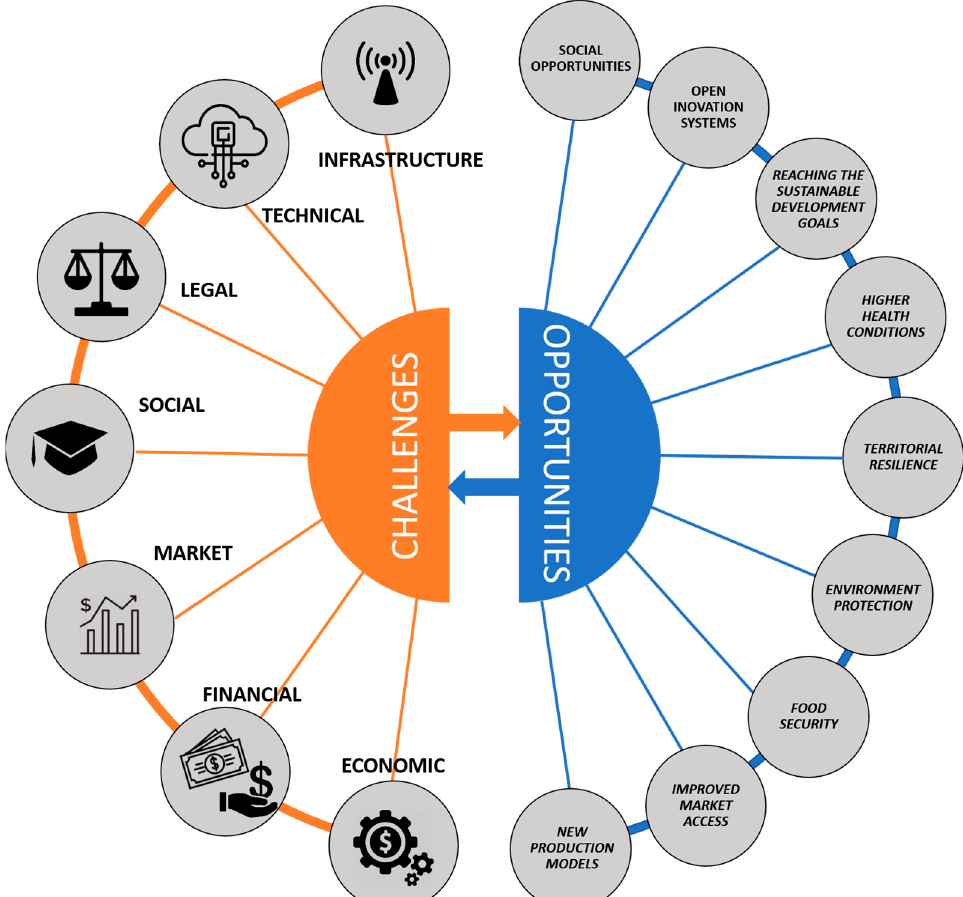
Figure 10. Challenges and opportunities of Spanish agriculture digitalization.